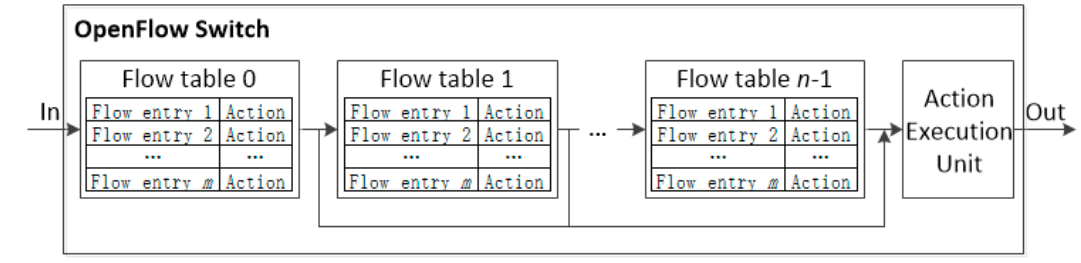
Figure 2. The pipeline processing with MFT.